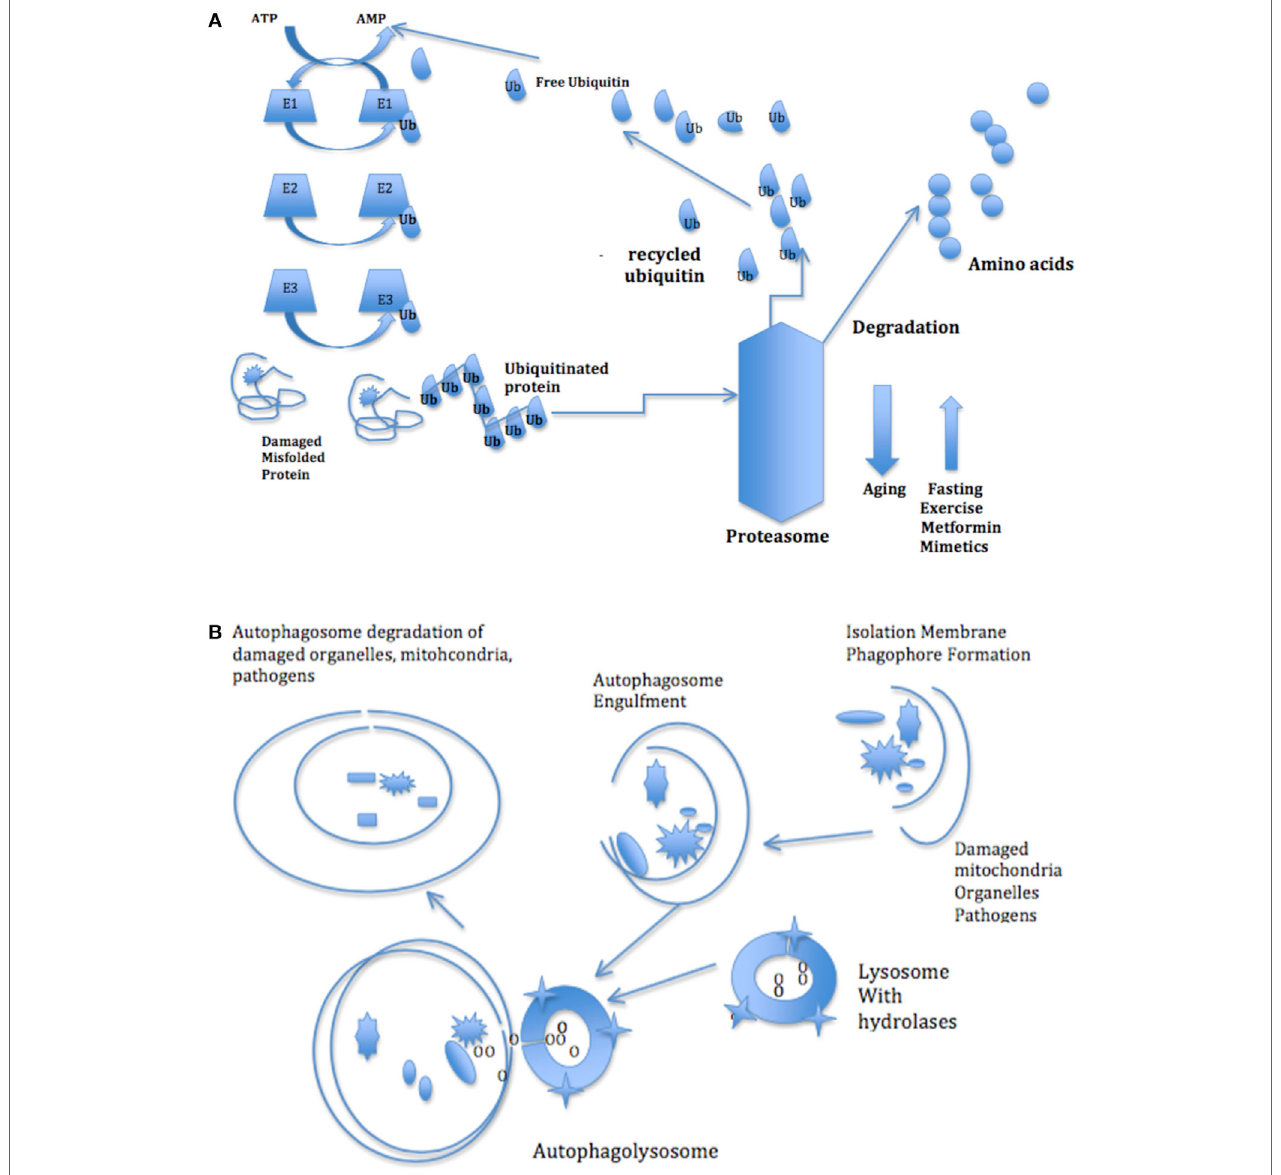
FigURe 3 | (A) The ubiquitin–proteasome pathway of protein degradation. Three different sets of enzymes—E1, E2, and E3, identify and categorize proteins in order to link ubiquitin or ubiquitin complexes to the damaged proteins. The ubiquitin-protein complexes pass through the proteasome where they are degraded and discharged as free amino acids into the cytoplasm. (B) The autophagy pathway of degradation of damaged organelles and pathogens. The autophagy system degrades larger aggregated proteins and cellular organelles, such as mitochondria, peroxisomes, and infectious organisms. The process involves membrane formation, fusion, and degradation. A small separate membrane called a phagophore forms and then forms the autophagosome that fuses with the lysosome. The autophagosome contents are degraded by lysosomal